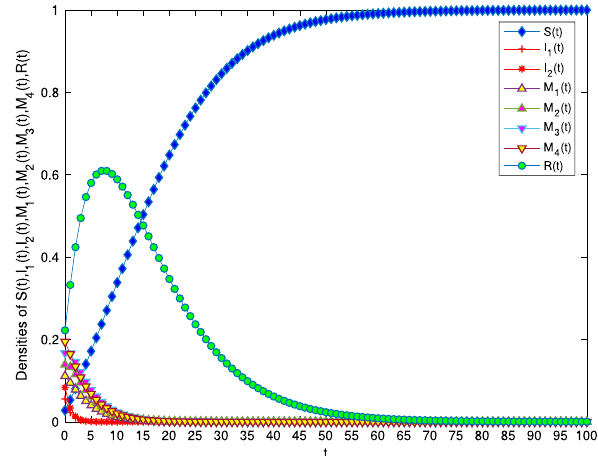
0 of system 1 with R 0 < 1 .